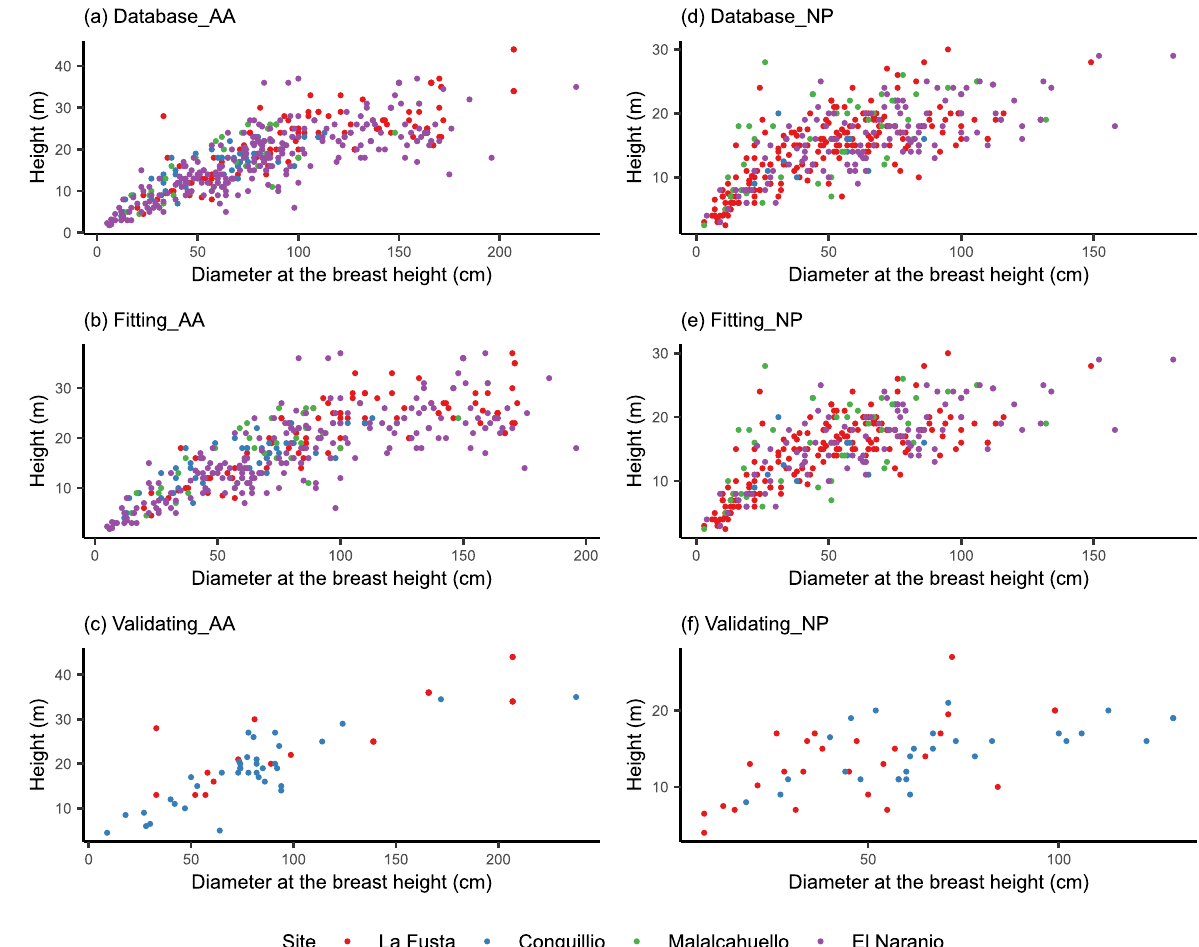
Fig. 2 Height plotted against DBH for the complete, fitting, and validating database of A. araucana ( a , b , and c ) and N. pumilio ( d , e , and f